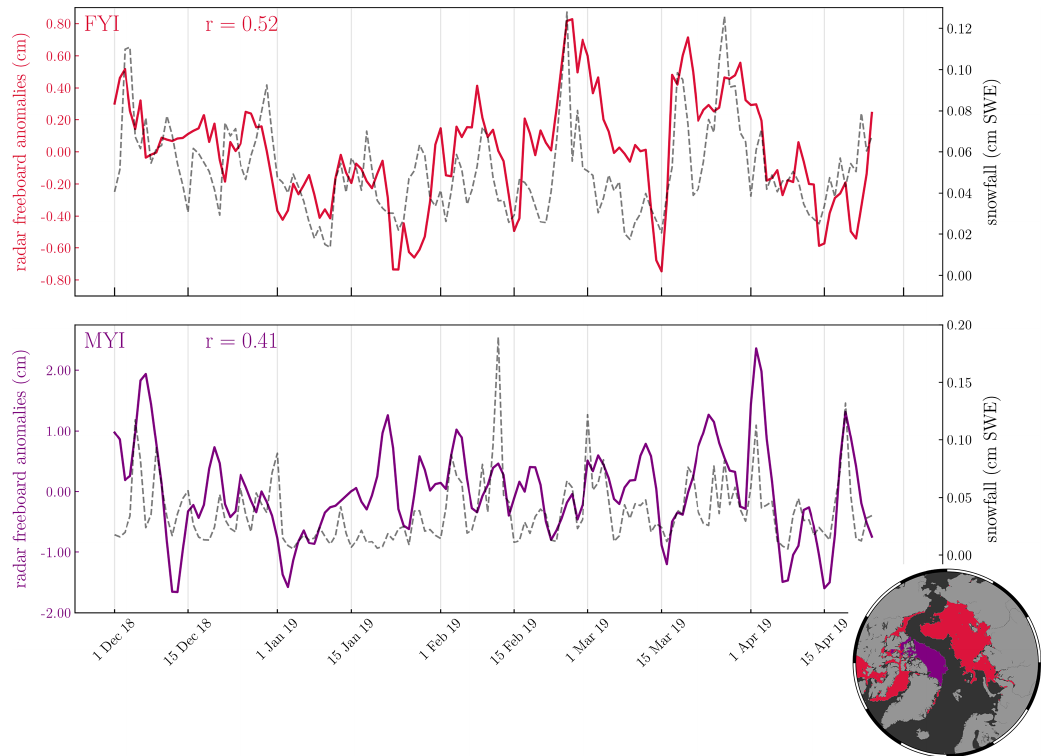
Figure 9. Time series of CS2S3 daily radar freeboard anomalies with daily ERA5 snowfall (cm snow water equivalent (SWE)). The cor- responding contour for FYI and MYI zones are given in the accompanying spatial plot, where each pixel represents a location which has remained either FYI or MYI for the entire 2018–2019 winter season. The Pearson correlation ( r ) between radar freeboard anomalies and snowfall are given for each